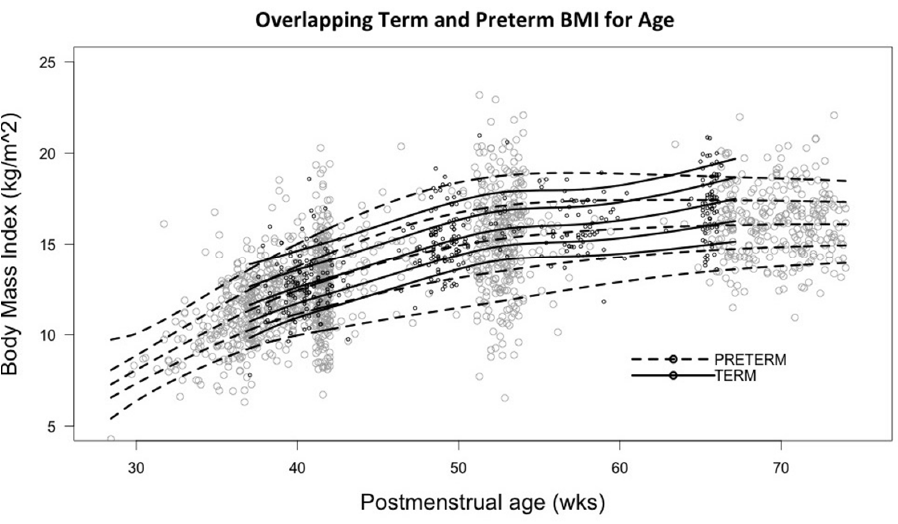
Figure 2. 10th, 25th, 50th, 75th, and 90th centiles of BMI for postmenstrual age in term and preterm infants based on the imputed data set.